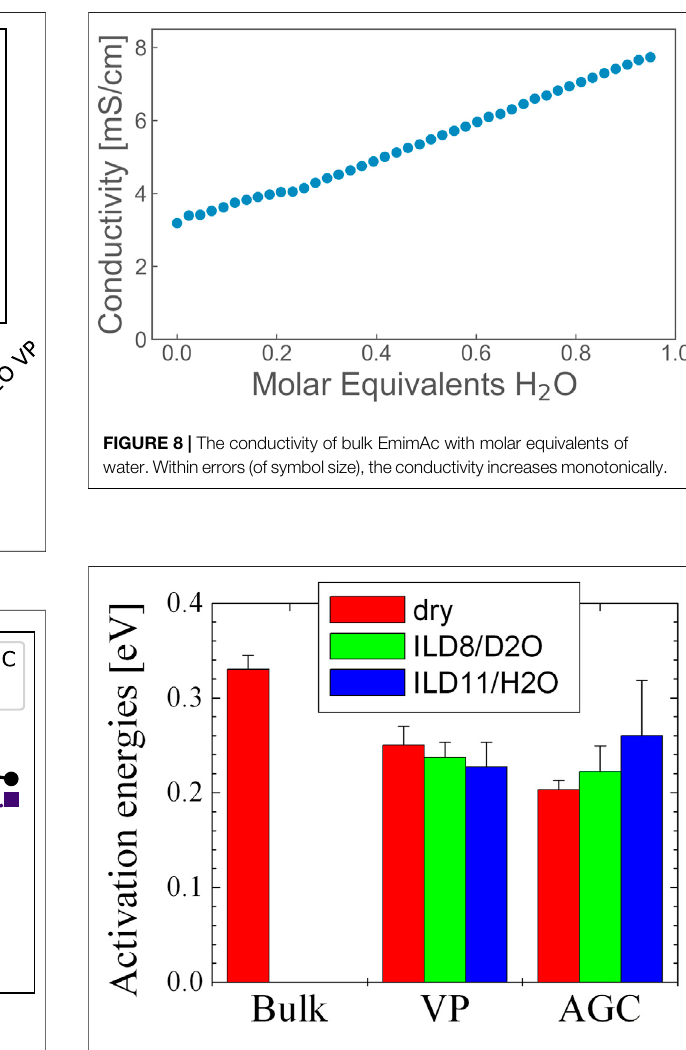
FIGURE 9 | The activation energies from Noferini et al. [8] and the current